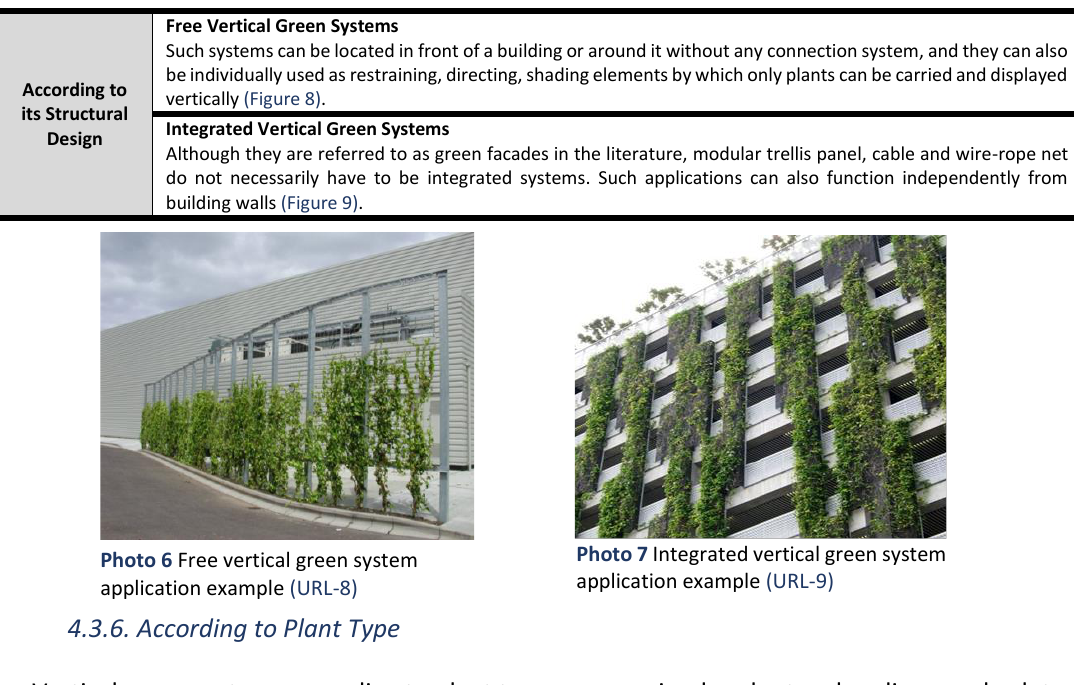
Table 7 Vertical green system classification according to its structural design